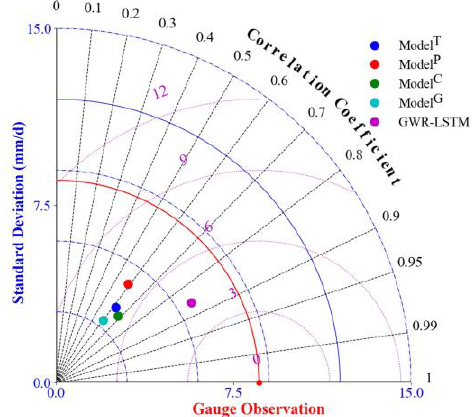
Figure 12. Taylor diagrams for the GWR-LSTM framework proposed in this study and the single-SPP fusion model (Model T , Model C , Model P , and Model G ) with reference to gauge observations.